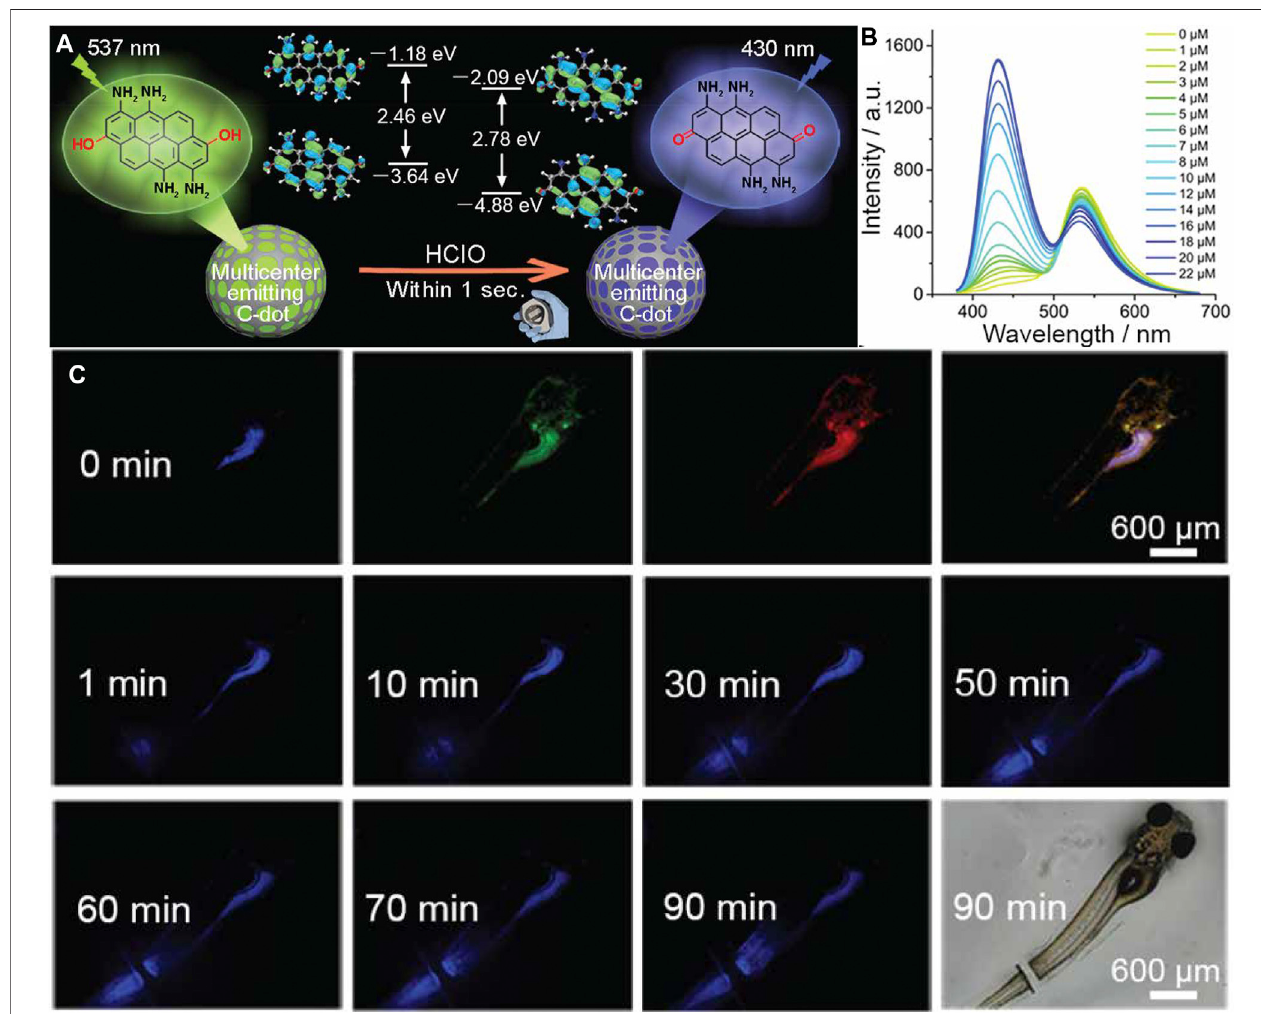
FIGURE5|(A) Schematicofthe “ multicenter-emitting ” carbondotforthedetectionofClO − .Here,duetothedifferencesinenergystatepresencewithinthecarbon dot,aratiometicsensorwasdesigned. (B) FluorescencespectrumofthecarbondotatdifferenceconcentrationsofClO − ,highlightingthechangeofpeakemissionfrom 537to430 nm. (C) Realtimemonitoringof invivo woundhealingonazebra fi shmodelusingcarbondots.At0 min,arepresentative fl uorescenceimagesofthezebra fi sh under blue, green, and red excitation were recorded pre-wound. Following amputation, fl uorescence within the blue channel increased over a 90-min period, signifying increased levels of ClO − . Reprinted (adapted) with permission from Wang et al. (2020b). Chem Mater. 2020, 32, 19, 8,146 – 8,157. Copyright 2020 American Chemical Society.